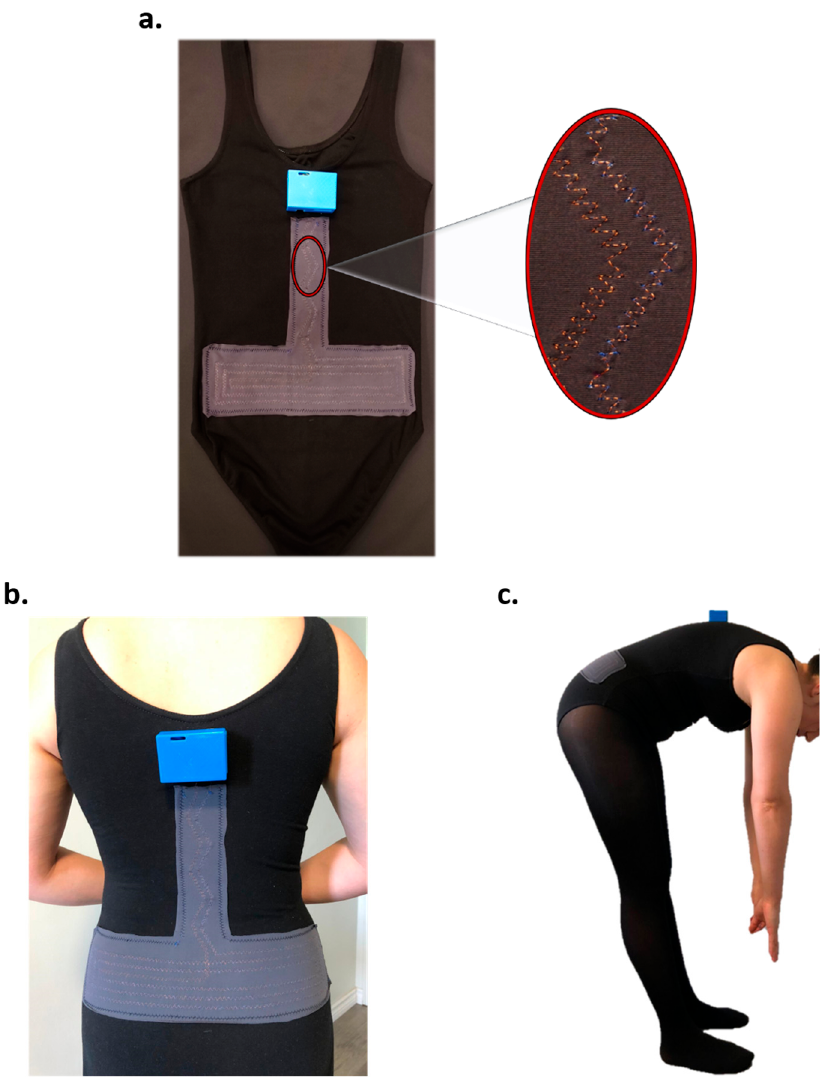
Figure 7. Smart garment: ( a ) Inductive strain textile sensor attached to a leotard [3]; ( b ) rear view of the smart garment worn by a participant; ( c ) participant performing forward bending while wearing the smart garment.